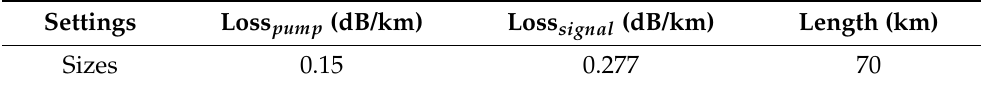
Table 1. Parameters in transmission